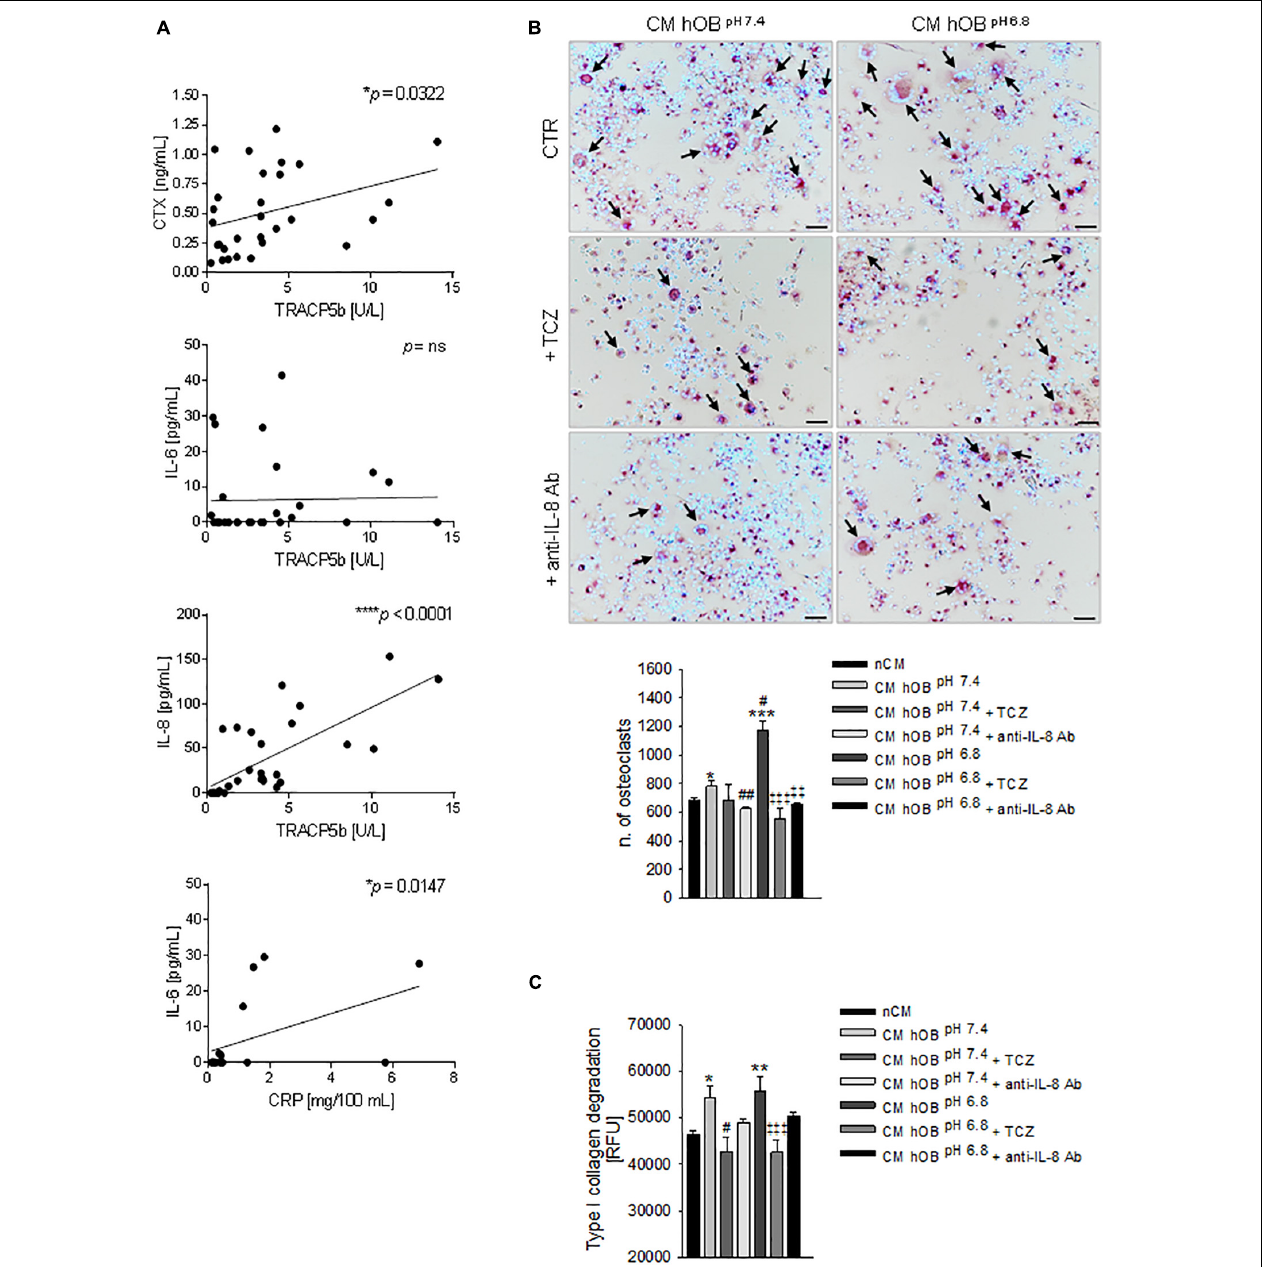
FIGURE 7 | Interleukin 6 (IL-6) and Interleukin 8 (IL-8) and osteolysis in BM. (A) Correlation in BM patients between serum levels of CTX and TRACP5b, IL-8, and TRACP5b, IL-6 and TRACP5b, and IL-6 and C-reactive protein (CRP). Mean ± SEM ( n = 29, * p < 0.05, *** p < 0.0001; n = 16, * p < 0.05 for IL-6 and CRP correlation). (B) On the left panel, representative images of TRACP positive multinucleated OC after 7 days of treatment with CM hOB pH 6 · 8 or CM hOB pH 7 · 4 added or not with the anti-IL-6 antibody, tocilizumab (TCZ) and the anti-IL-8 antibody (anti-IL-8 Ab) (scale bar 50 µ m). On the right panel, graph of the quantification of n. of mature OC. Mean ± SEM ( n = 8, * p < 0.05 and *** p < 0.001 versus nCM, # p < 0.05 and ## p < 0.05 versus CM hOB pH 7 · 4 ; ‡‡ p < 0.01 and ‡‡‡ p < 0.001 versus CM hOB pH 6 . 8 ). (C) Bone resorption activity of OC treated with the same conditions of (B) , and measured as type I collagen degradation. In this case, TCZ and anti-IL-8 Ab were added starting from day 7, after that mature OCs were formed. Mean ± SEM ( n = 15, * p < 0.05 and ** p < 0.01 versus nCM, # p < 0.05 versus CM hOB pH 7 · 4 ; ‡‡‡ p < 0.001 versus CM hOB pH 6 . 8